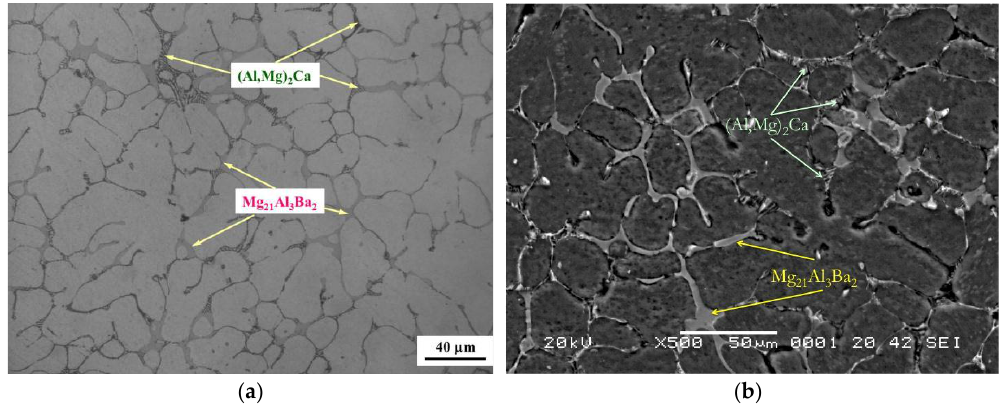
Figure 1. ( a ) Optical microstructure and ( b ) SEM micrograph reveals the morphologies of the second phases in the ABaX422 alloy in the as-cast condition.